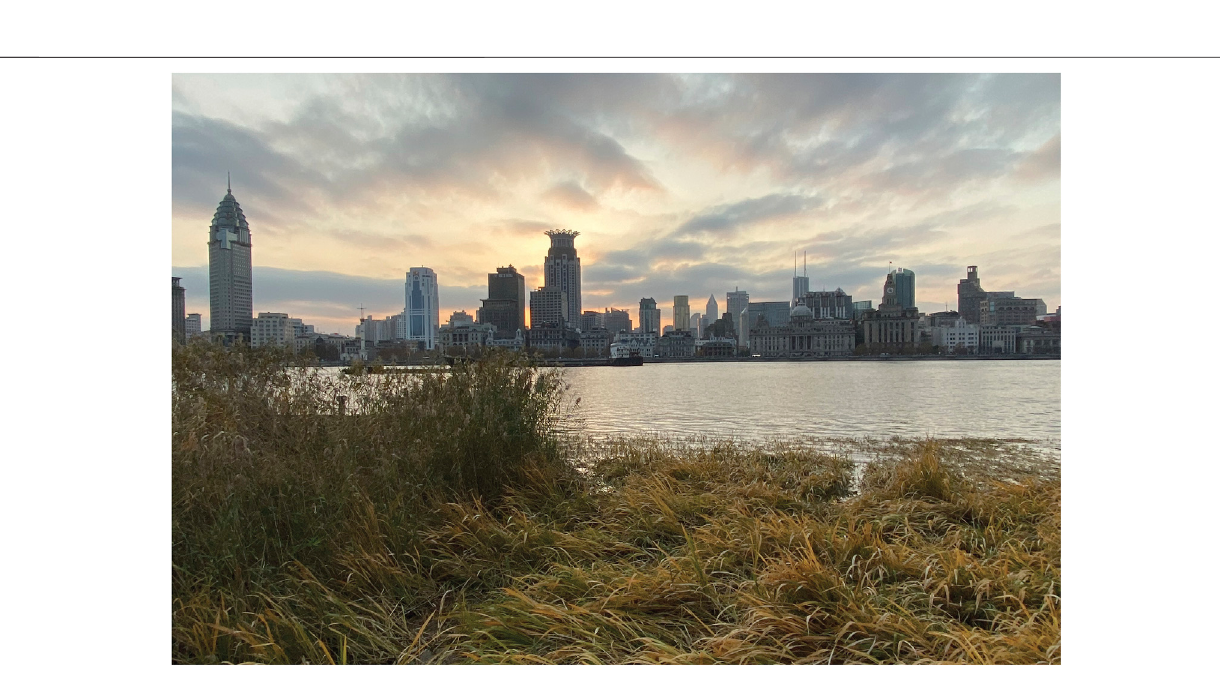
Frontiers in Environmental Science |